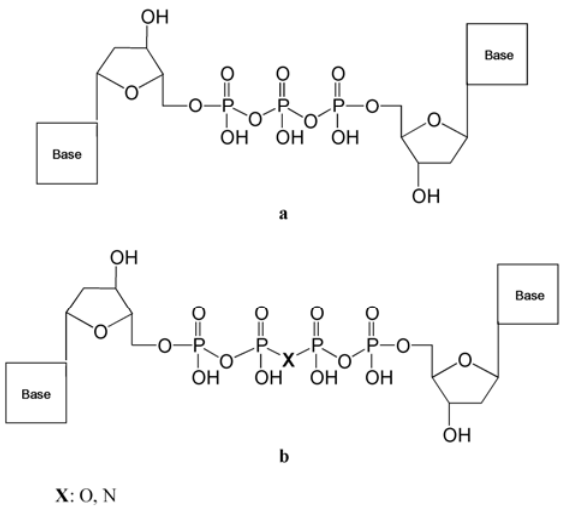
Figure 4. Structures of dinucleoside tri- and tetraphosphates